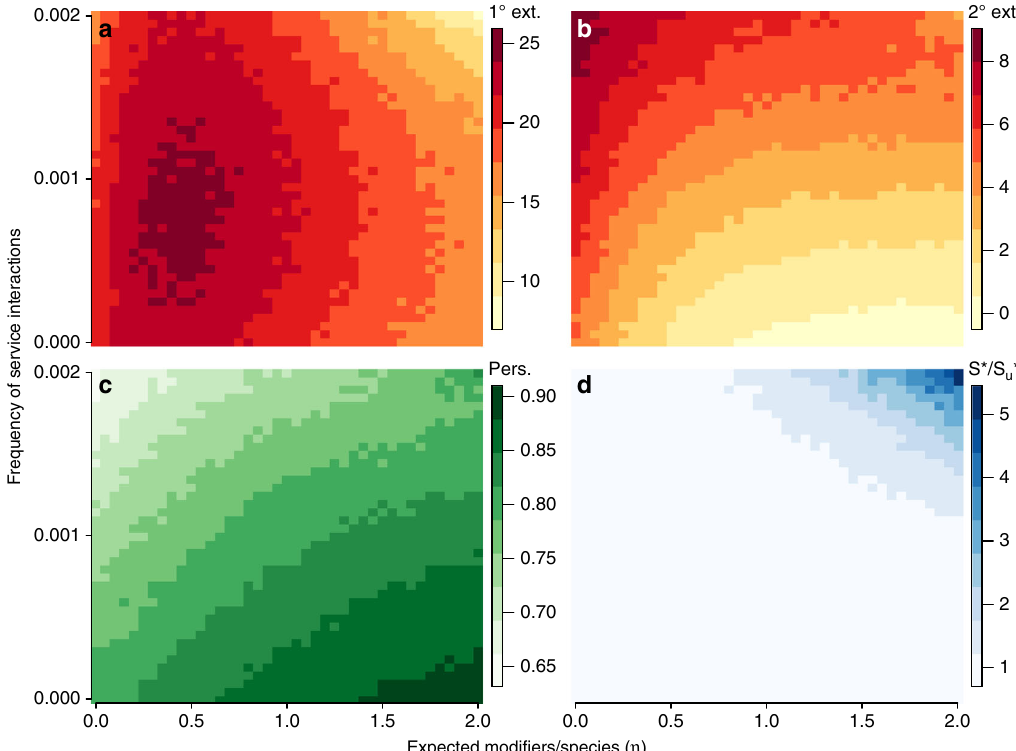
Fig. 4 Community stability as a function of the frequency of service interactions and modi fi ers per species. a Mean rates of primary extinction, where primary extinctions occur from competitive exclusion of consumers over shared resources. b Mean rates of secondary extinction, which cascade from primary extinctions. c Mean species persistence. d The ratio S (cid:2) = S (cid:2) , where S (cid:2) denotes steady states for systems where all engineered modi fi ers are unique u u to each engineer, and S * denote steady states for systems with redundant engineering. Higher values of S (cid:2) = S (cid:2) mean that systems with redundant engineers u have higher richness at the steady state than those without redundancies. Primary and secondary extinction rates were evaluated at the community level, whereas persistence was determined for each species and averaged across the community. Each measure reports the expectation taken across 50 replicates. See “ Methods ” and Supplementary Note 2 for parameter